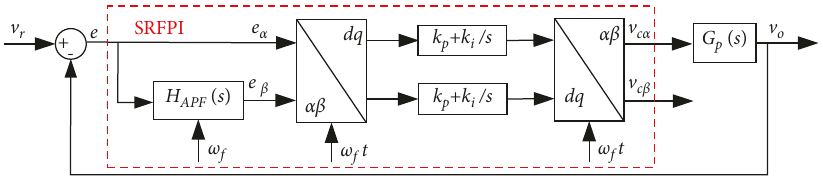
Figure 8: The equivalent control block of SRFPI.